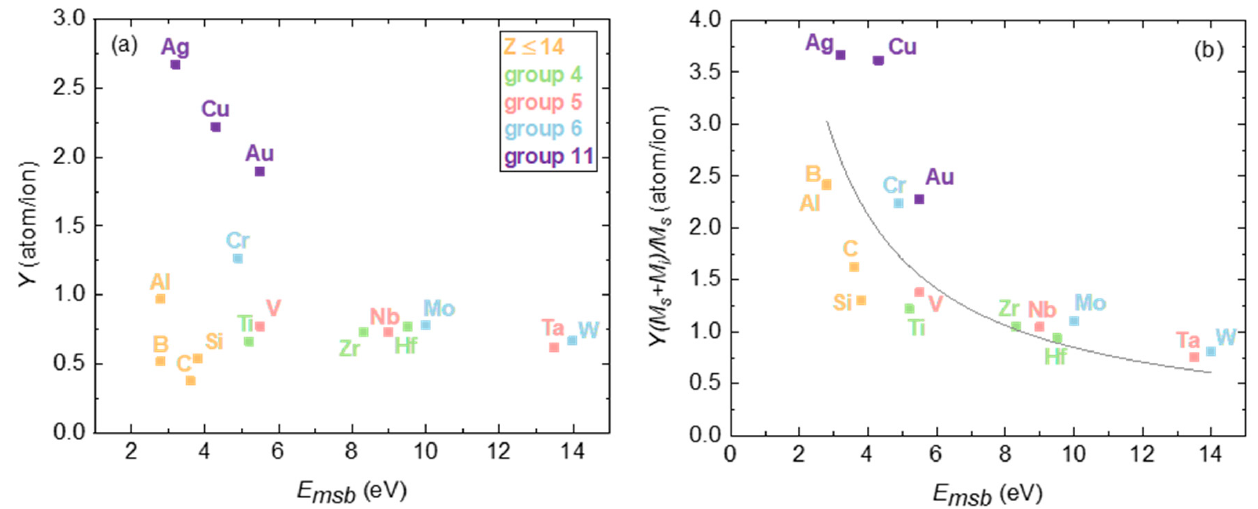
Figure 11. ( a ) The sputtering yield and ( b ) the sputtering yield divided by the target-to-ion mass ratio for different elements in dependence of the modified surface binding energy. The 1/ E msb trend (cid:16) (cid:17) M s is found in the case of Y / , which is in accordance with the simplified sputtering yield ( M s + M i ) formula, Equation (20). The total sputtering yields were calculated by SRIM using Ar ions impinging normally to the surface with an energy of 600